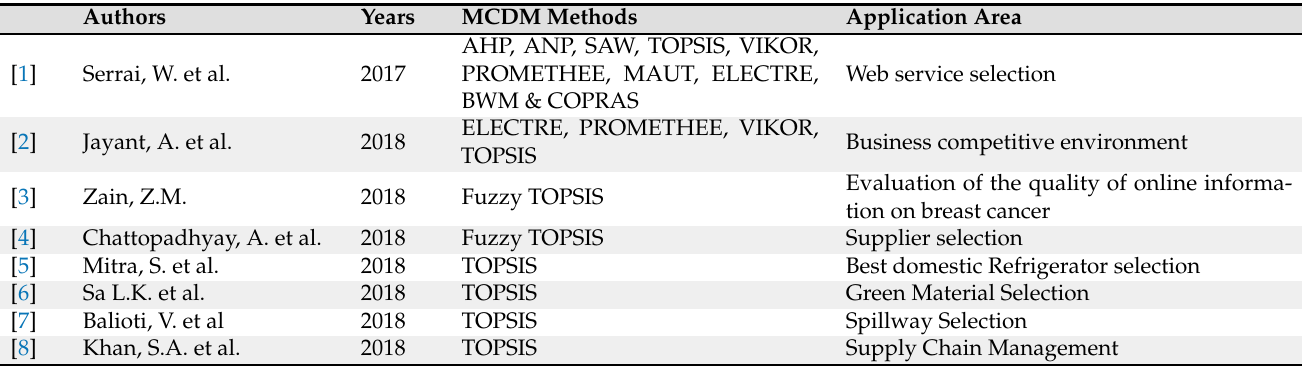
Table 1. Literature review with respect to different MCDM techniques and